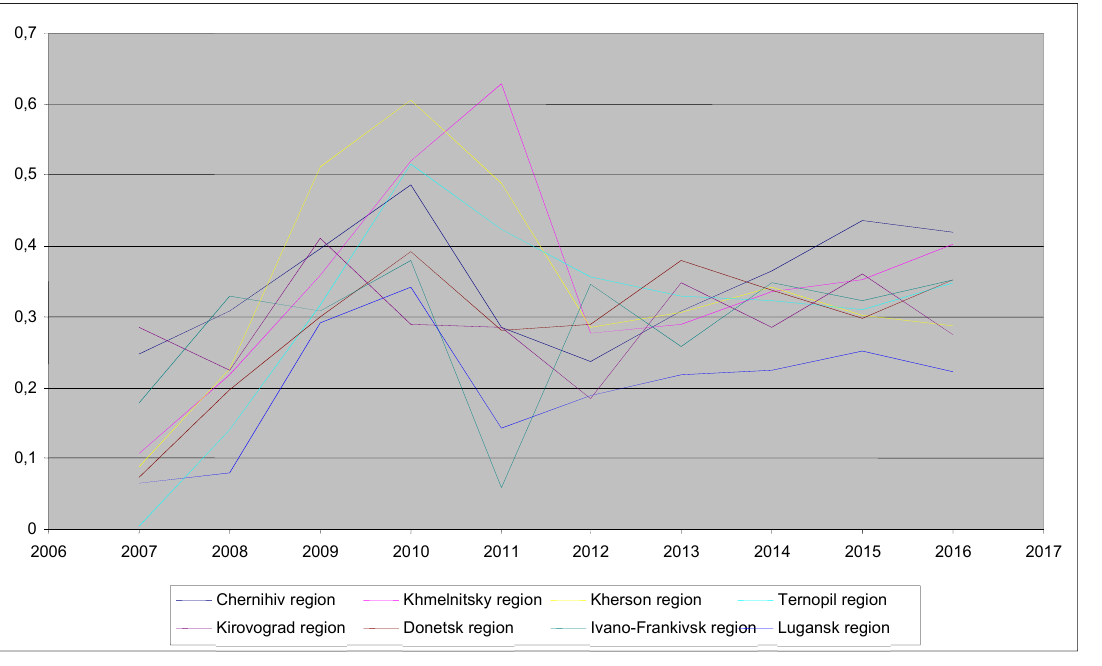
Fig. 3. Dynamics of the modified level of regional development with an average value of the integral indicator less than